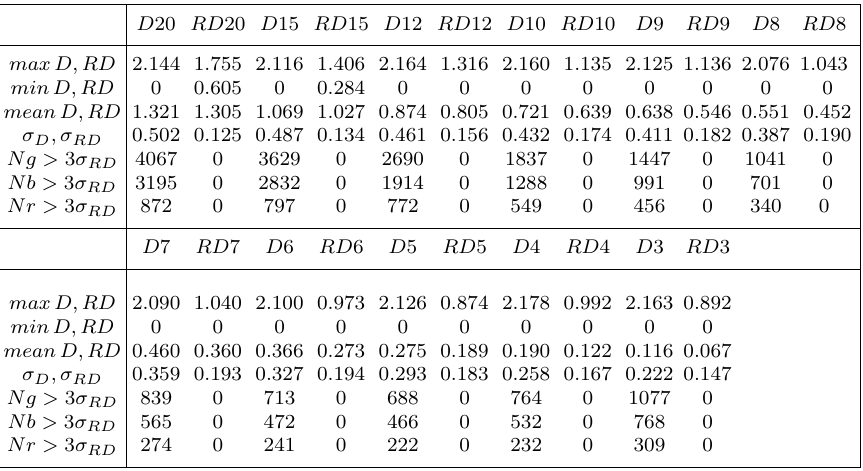
Table 1. Main statistical parameters of the distributions of dimensions D and RD . The numbers in the header row are the scale factors Mf (the limiting radii of the EMV in parsecs, inside which the fractal dimension was